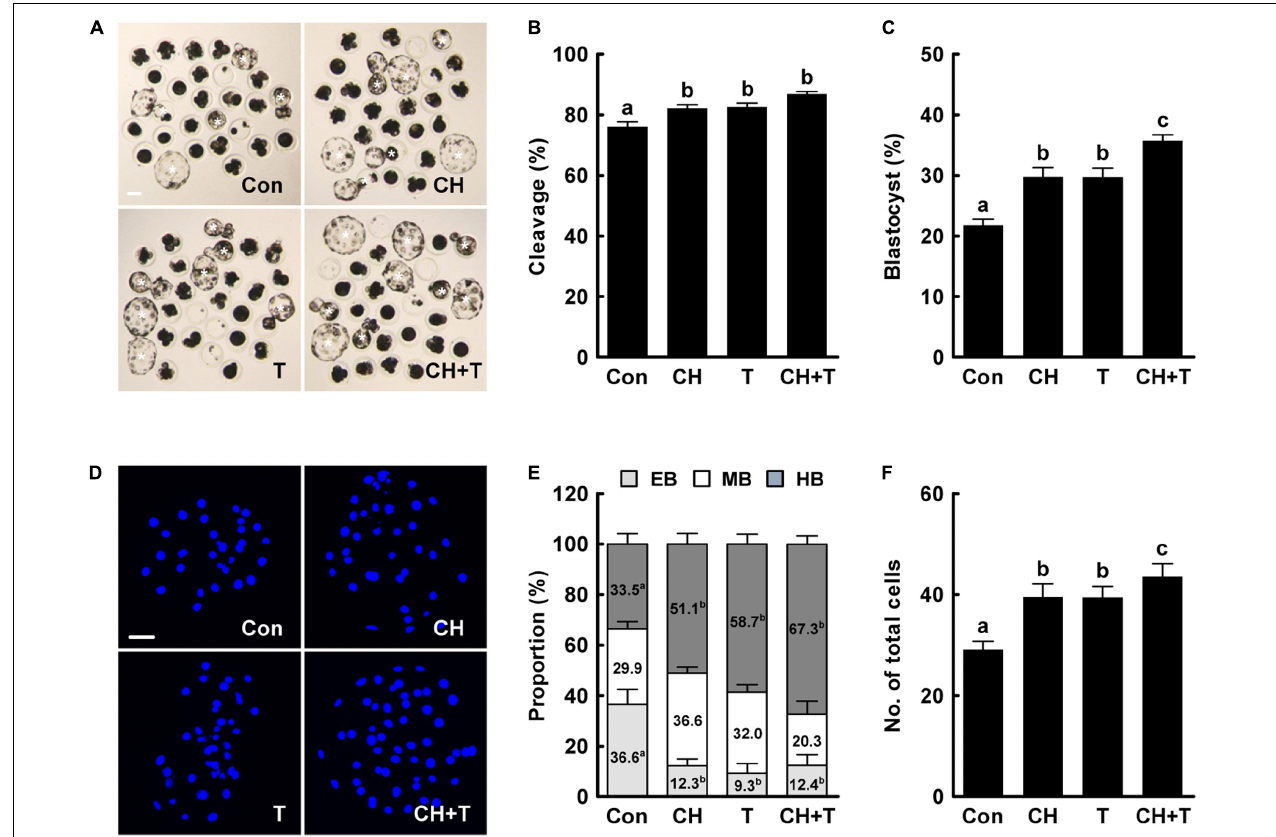
FIGURE 1 | Effects of chaetocin, TSA, and the combination on in vitro development of porcine SCNT embryos. (A) Representative images of cultured blastocysts (white asterisks). Bar = 100 µ m. Quantification of (B) the cleavage rate and (C) the blastocyst formation rate ( n = 139 per group). (D) Representative nuclear-stained images of blastocysts. Bar = 50 µ m. Quantification of (E) the various blastocyst stages and (F) total cell numbers (Con; n = 30, CH; n = 41, T; n = 41, CH + T; n = 49). The data are from four independent experiments and are means ± SEM. Values with different superscripts differ significantly ( P < 0.05). Con, control;